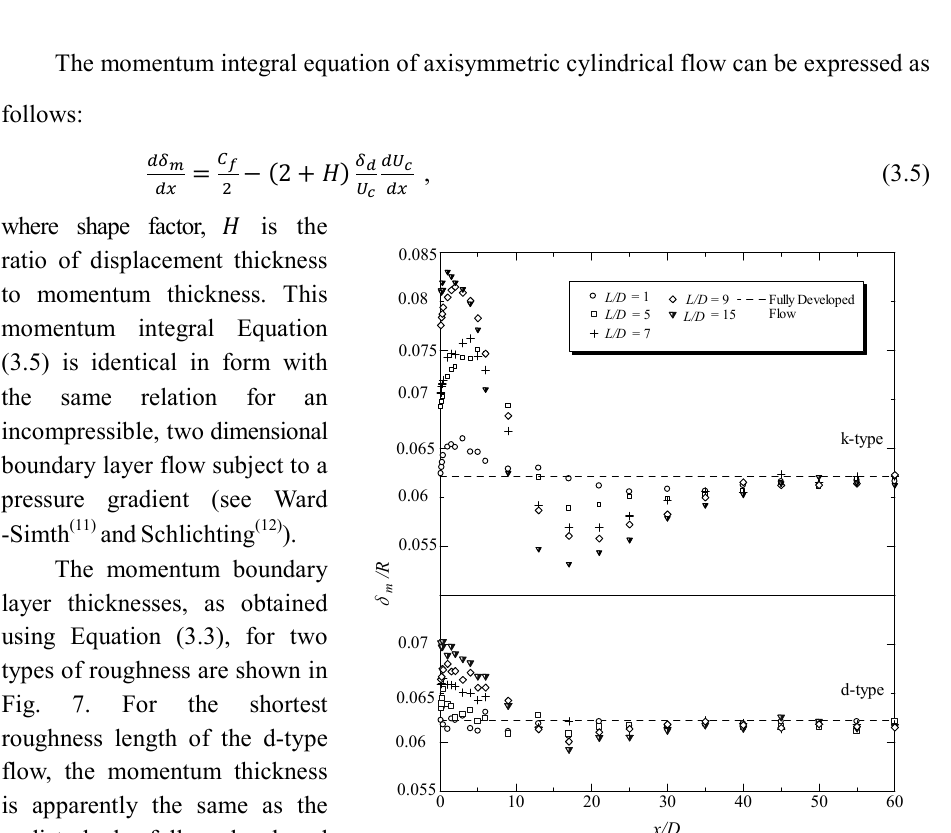
Fig. 7 Momentum thickness of two types of roughness appearing in the downstream of the